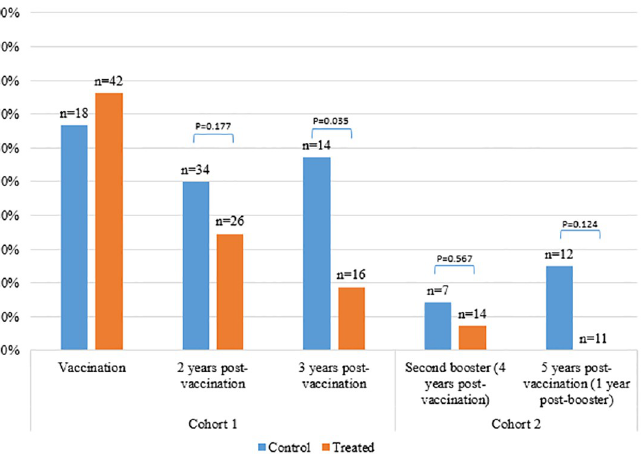
Fig 1. Percentage of treated cattle in Cohort 1 recorded as pregnant at sample points over time following vaccination with GonaCon in 2015, compared to untreated (control) cattle. Control group includes all untreated females captured at sampling point in Cohort 1, and additional untreated cattle, added from Cohort 2, included from 2 years post-vaccination. Treated cattle were administered a booster dose 3–6 months and 4 years after initial vaccination. Group sample size indicated on each